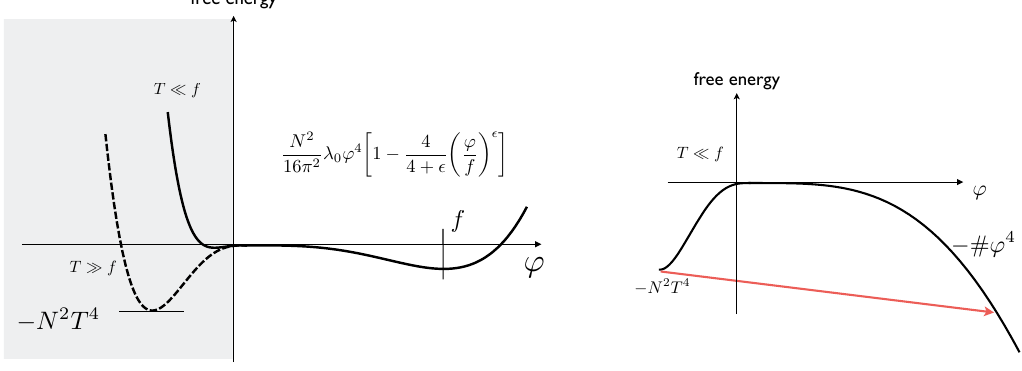
Figure 5 . On the left, free energy for di(cid:11)erent values of the temperature that a(cid:11)ects the potential of the CFT phase. The universe is trapped in the false vacuum up to low temperatures where the relevant region for tunneling is well approximated by a negative quartic potential (right